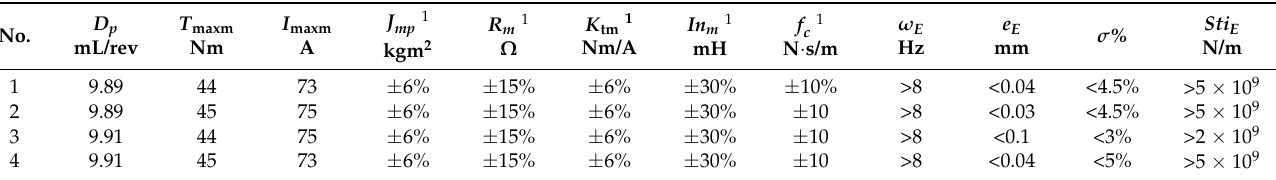
Table 5. The design of experiments for verifying the selected